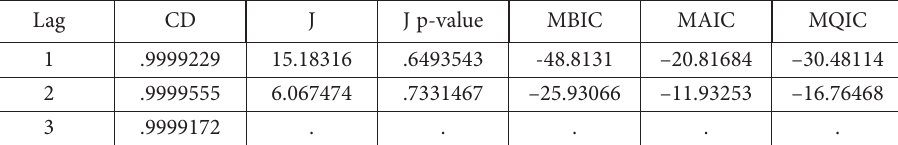
Table 6. Panel VAR optimal moment and model selection criteria (varsoc) (source: author’s calculation STATA program, 2021) Lag